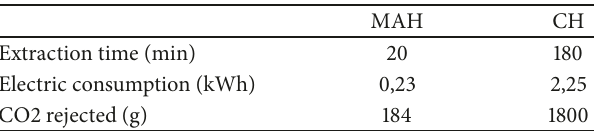
Table 3: Energy consumption and CO2 rejected of CH and MAH methods.